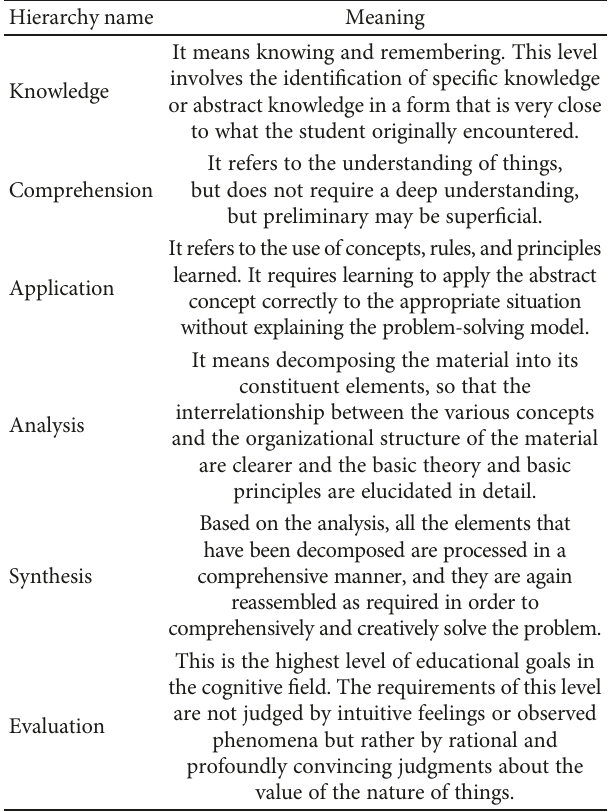
Table 1: Evaluation level of the public ’ s recycled water cognition. Hierarchy